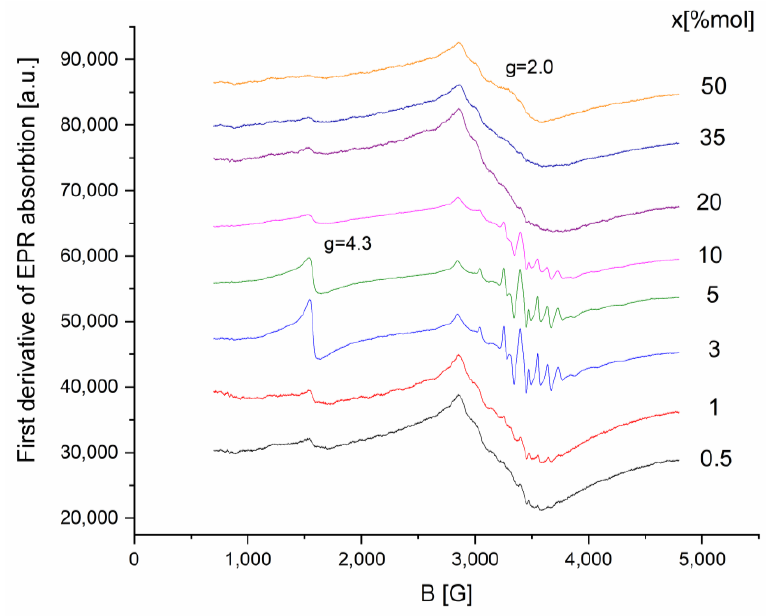
Figure 2. The first derivative of EPR absorption for x(Fe 2 O 3 · V 2 O 5 ) · (100 − x)[P 2 O 5 · CaO] glasses systems.